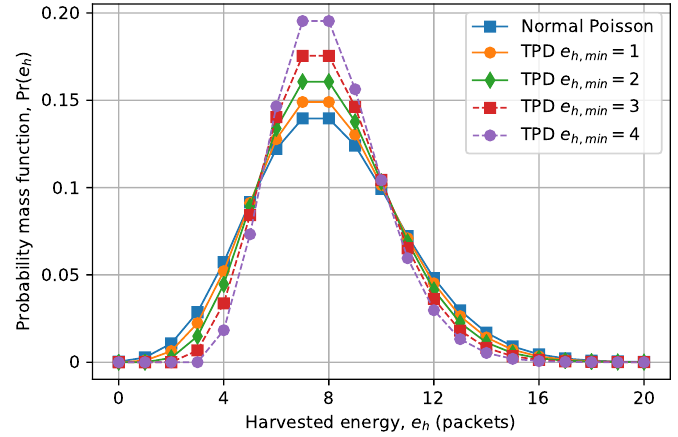
Figure 3. Comparison between the normal Poisson distribution and the transformed Poisson distribution (TPD) with e h , avg = 8 and different values of e h , min